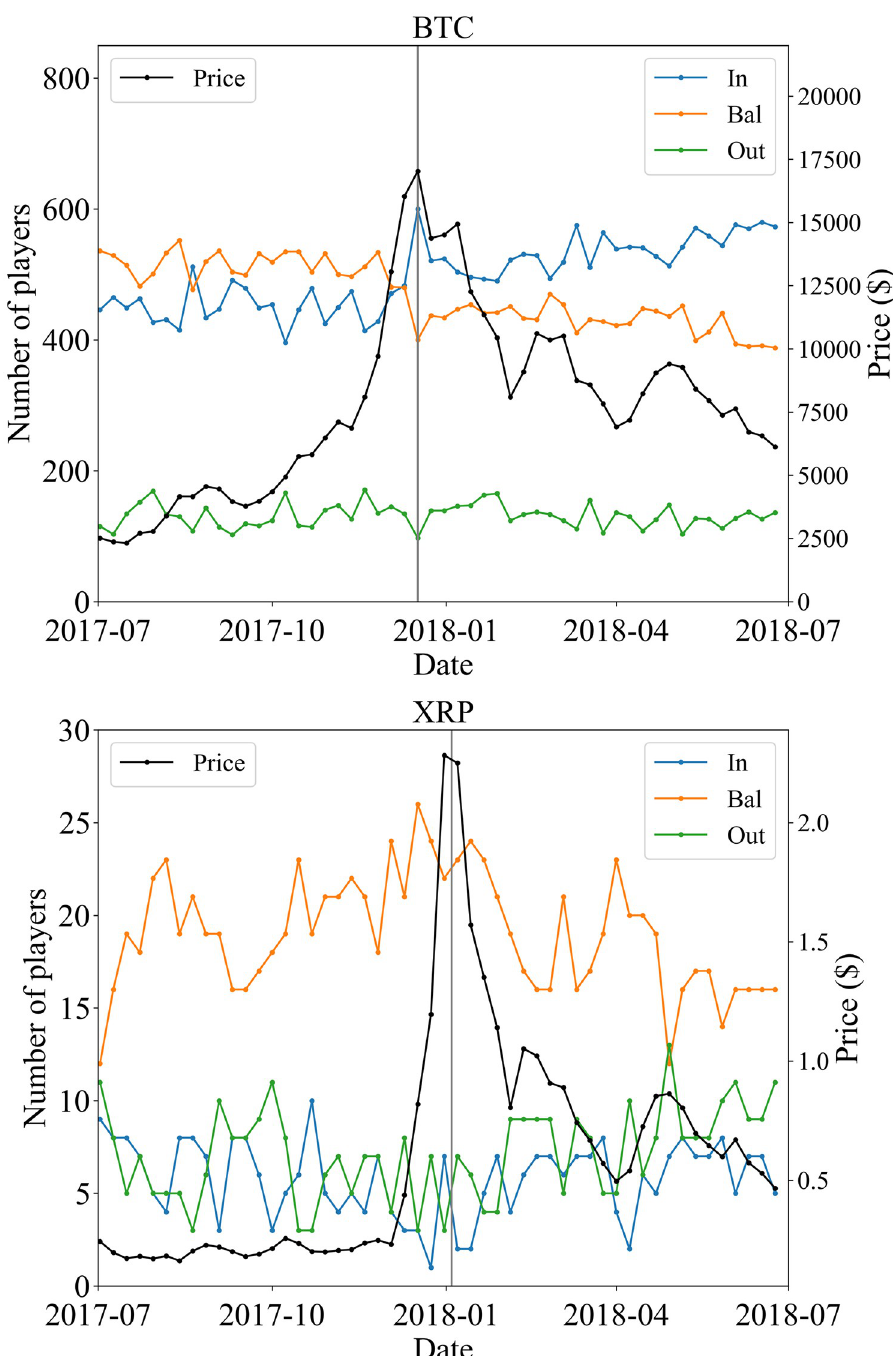
Fig 4. Number of In- (blue), Bal- (orange), and Out- (green) regular players, | P ( Bitcoin (top) and XRP (bottom). The black line represents the one-week-average price. The week that contains the day of the peak, t = 25 is represented by the gray vertical